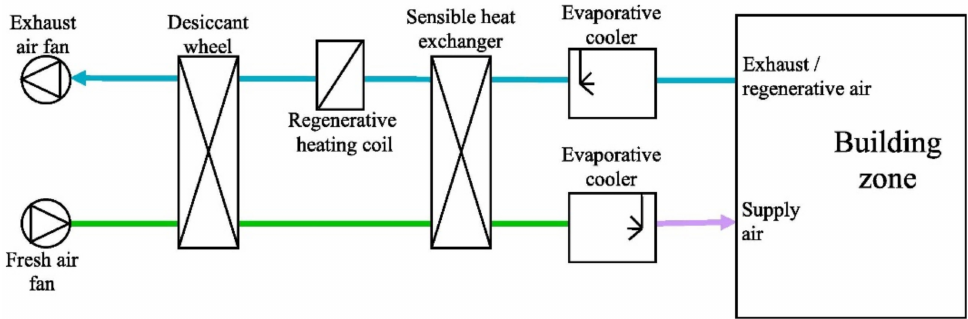
Figure 4. Schematic diagram of solid desiccant-based evaporative cooling system